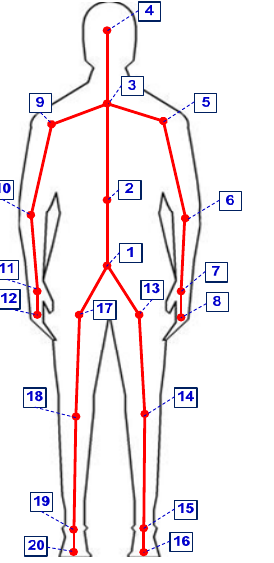
Figure 4. Diagram of the human joi nts with 3D coordinates ( x, y, z )